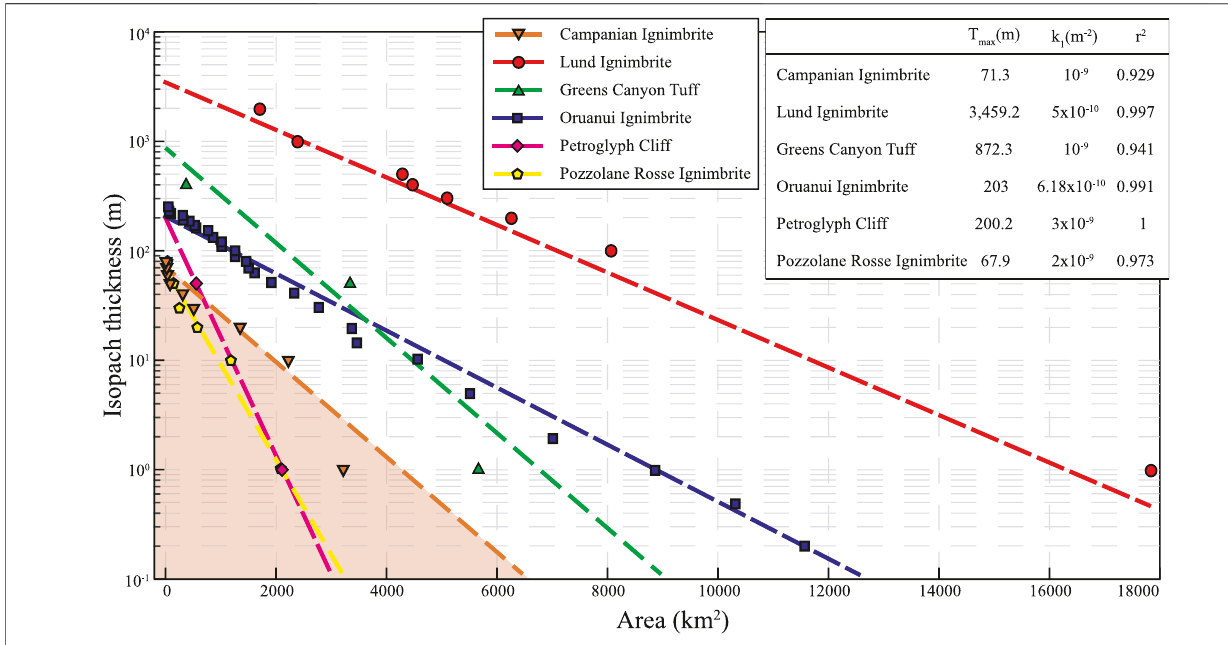
FIGURE 7 | Thickness (in log scale) vs. the cumulative area enclosed in that thickness of each isopach of different ignimbrites [the Campanian Ignimbrite (CI) in orange; the Lund Ignimbrite in red, Best et al., 2013a; the Greens Canyon Tuff in green, Best et al., 2013a; the Oruanui Ignimbrite in blue, Wilson, 1991; the Petroglyph Cliff in pink, Best et al., 2013a; and the Pozzolane Rosse Ignimbrite in yellow, Giordano and Doronzo, 2017]. The dashed lines represent the fi t of each ignimbrite. The values of the fi tting (T max , k 1 , and r 2 ) are reported in the upper right corner. The plotted CI points are those obtained by the isopach map. The CI volume is the integrated area displayed in